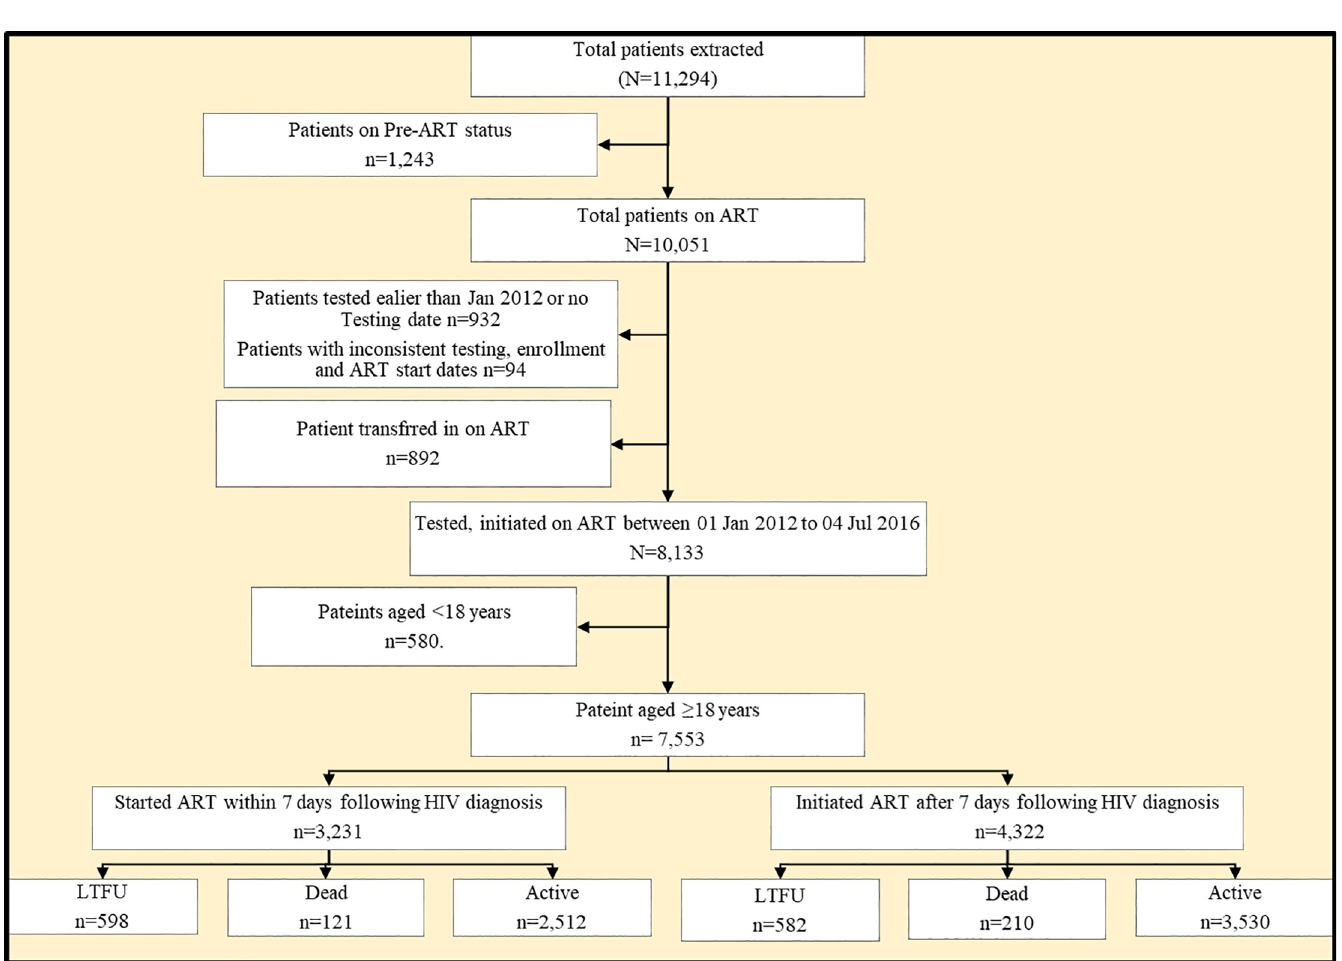
Fig 1. A flow diagram showing patients abstraction and inclusion into the study and their